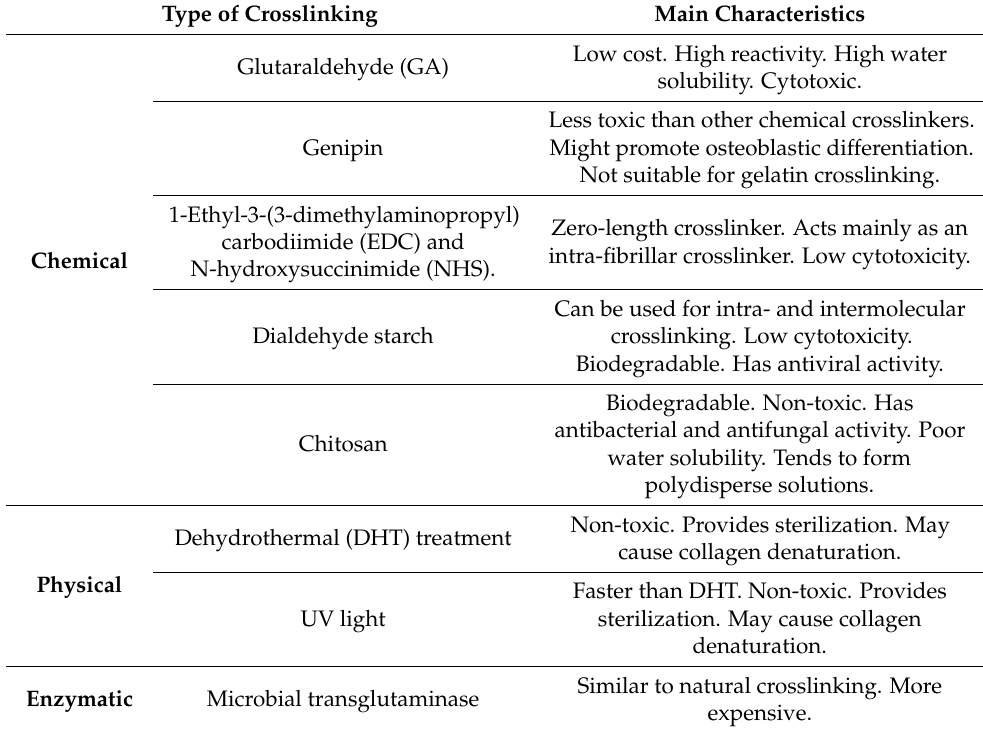
Table 2. Main methods for crosslinking collagen, according to